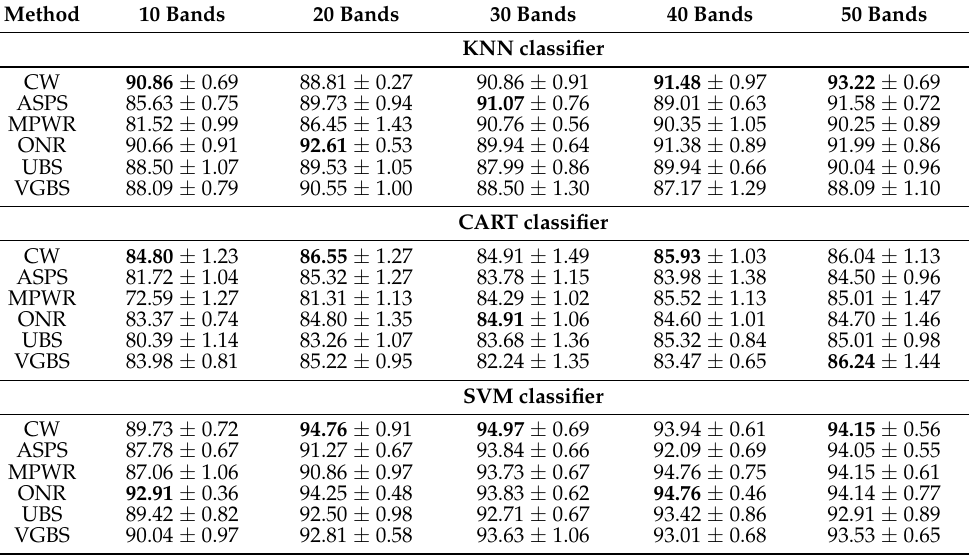
Table 2. Botswana image results ( overall accuracy and standard deviation in %